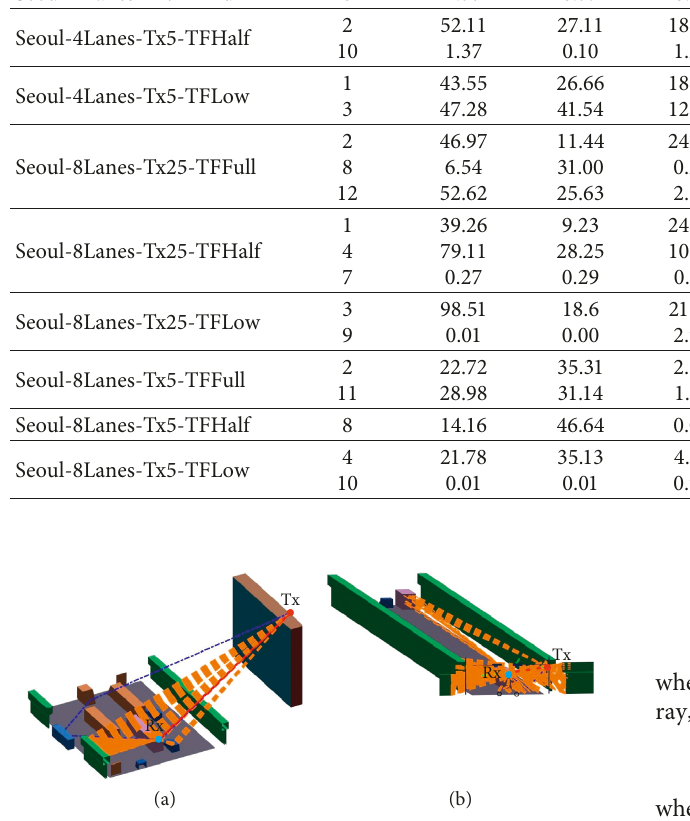
Figure 11: Rays in the main lobes of the transceiver. (a) Reflected rays aligned with the main lobe. (b) Scattered rays aligned with the main lobe.